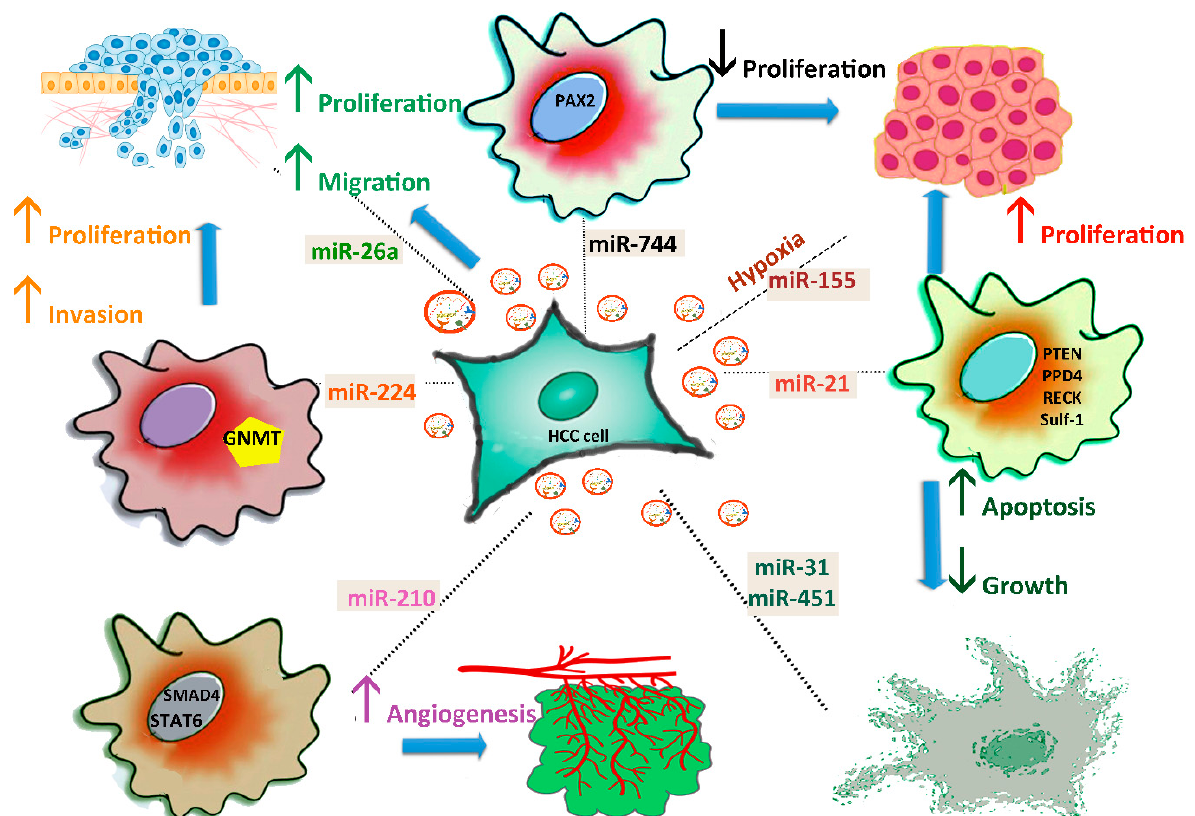
Figure 2. Roles of exosomal miRNAs in HCC progression. HCC cells secrete exosomes and affect proliferation by transferring miR-744, miR-21, and miR-26a into neighbouring cells. Angiogenesis is stimulated by miR-210, which blocks the SMAD4 and STAT6 pathways, while apoptosis is activated by miR-31 and miR-451. Inhibition of GNMT by miR-224 promotes the proliferation and invasion of HCC cells. miR-155 secretion increases under hypoxic conditions.